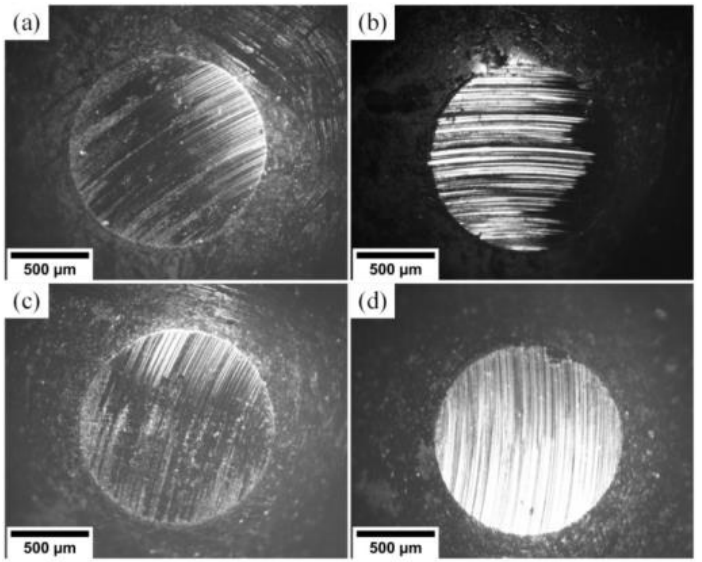
Figure 6. Wear scars on the 100Cr6 ball surface for substrates: ( a ) S1 (Al/Cr = 1.2), ( b ) S2 (Al/Cr = 0.8), ( c ) S3 (Al/Cr = 0.5), ( d ) S4 (Al/Cr = 0.2).